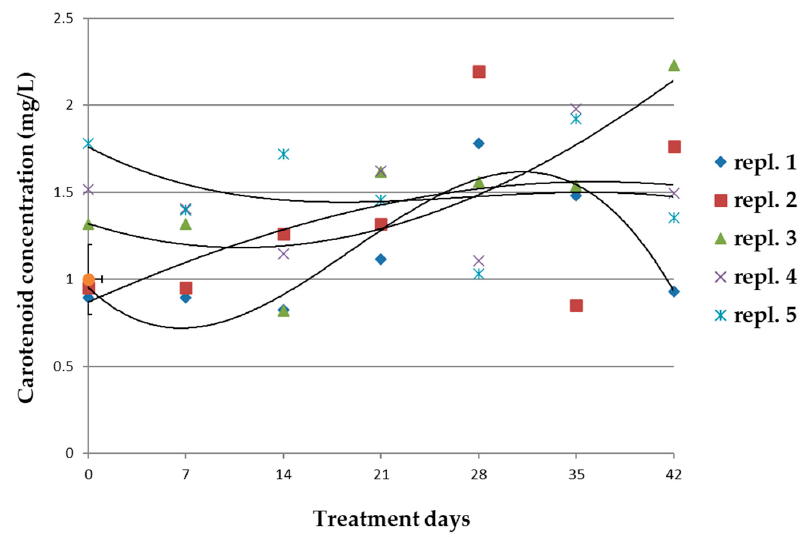
Figure 6. Concentration of carotenoids in biological replicates (n = 5) of A. maxima cultivations treated with 0.2 mM glyphosate for 42 days. Mean concentration values ( ± ES) of the reference cultivations and the regression line (dotted line) have been reported. Regression lines were calculated for each sample group. Statistical data and parameters are reported in Supplementary Table S1H.